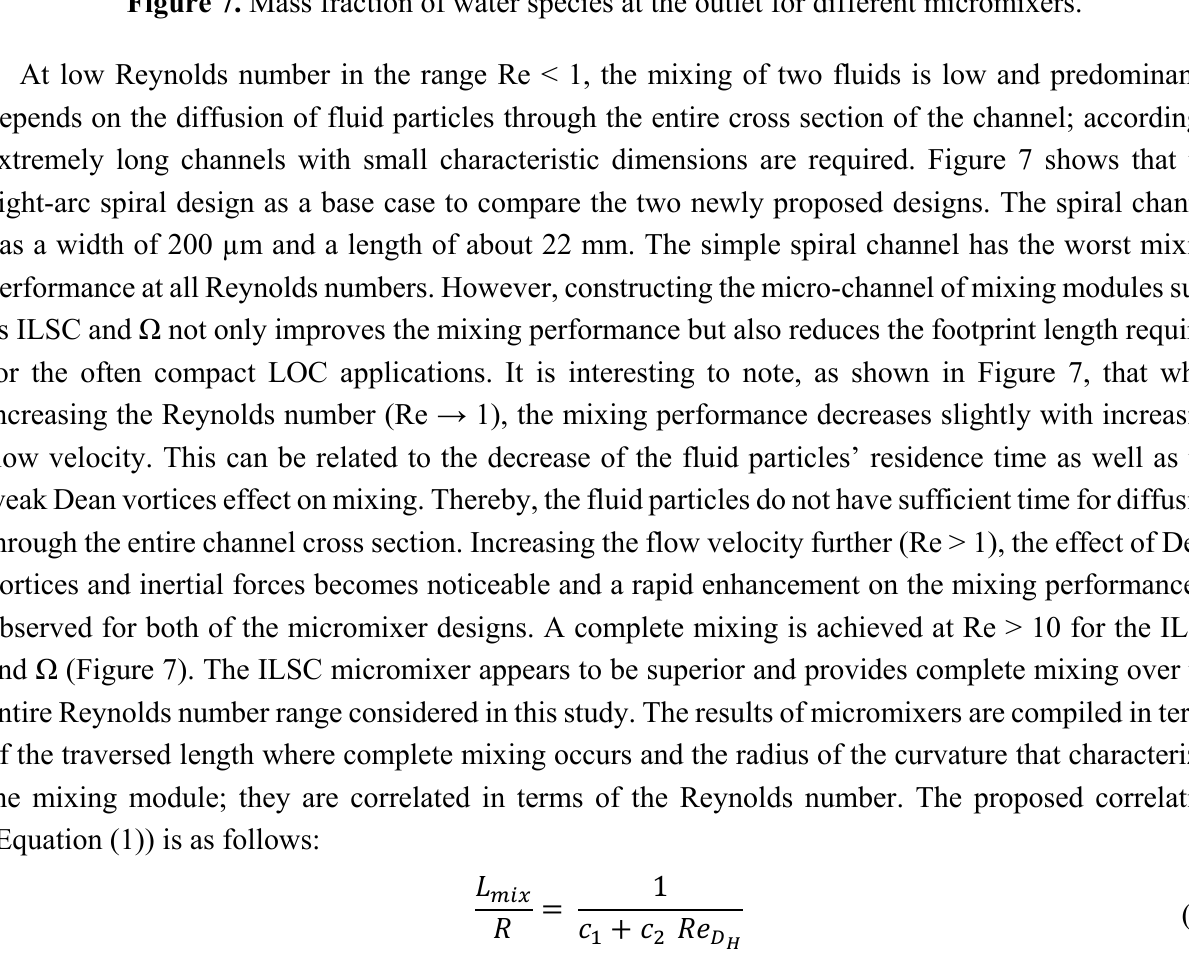
Figure 7. Mass fraction of water species at the outlet for different